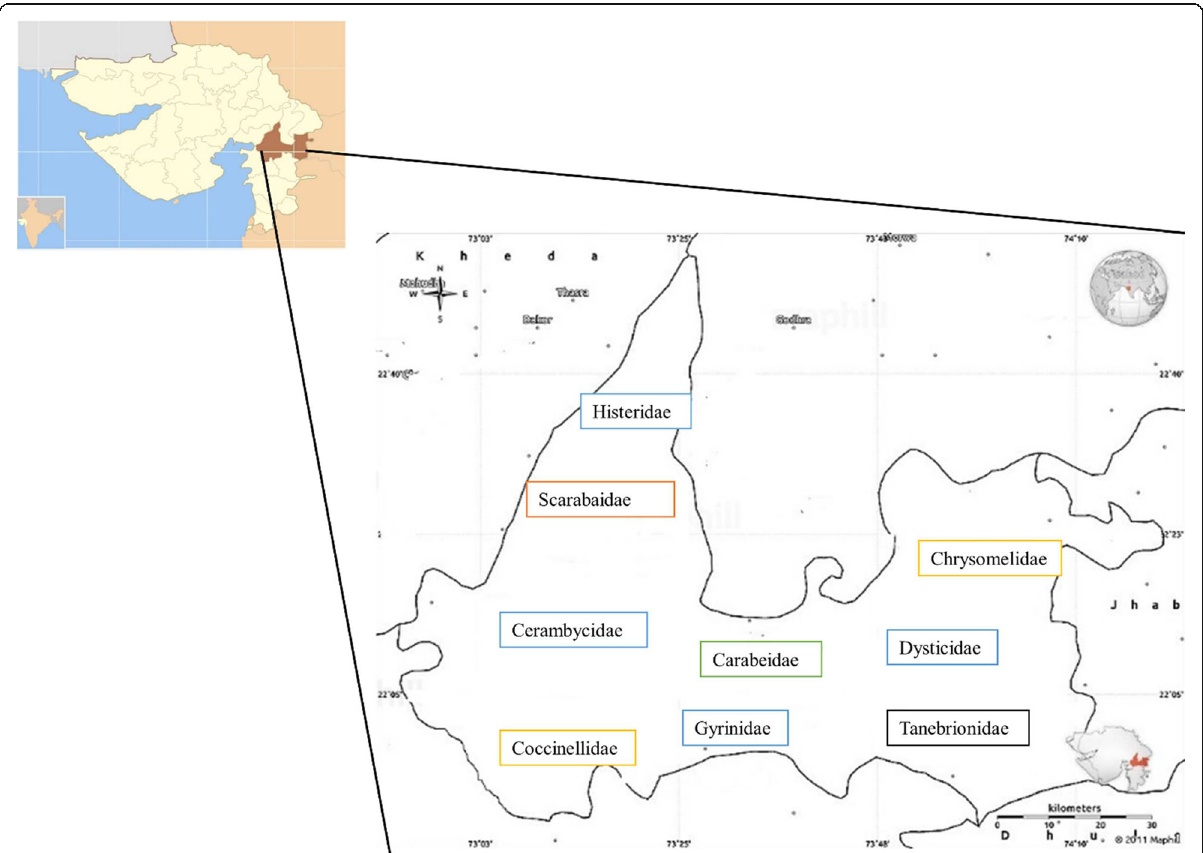
Fig. 1 A district map of Vadodara with its latitudinal (22.310696) and longitudinal (73.192635) extents, where only the dominant and selected families are shown in particular area of